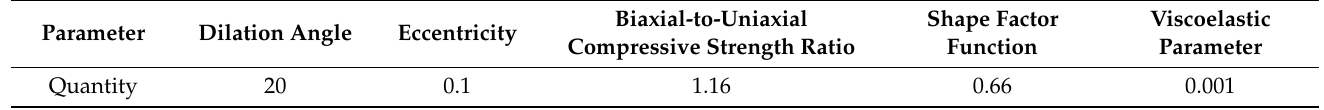
Table 1. Parameters of concrete damage plastic (CDP) model used here.